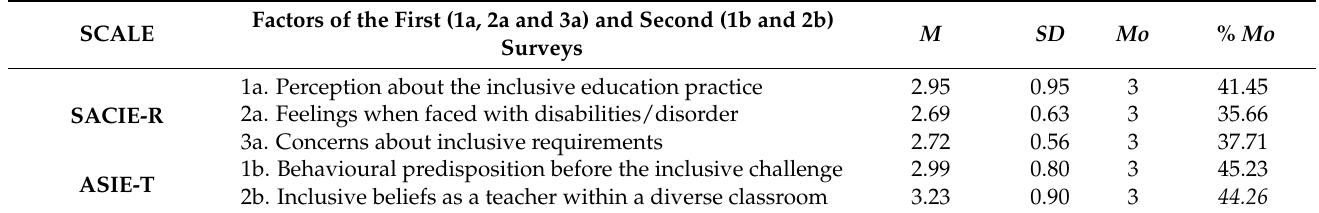
Table 1. Correlationals among attitudinal factors (1a, 2a, 3a, 1b,